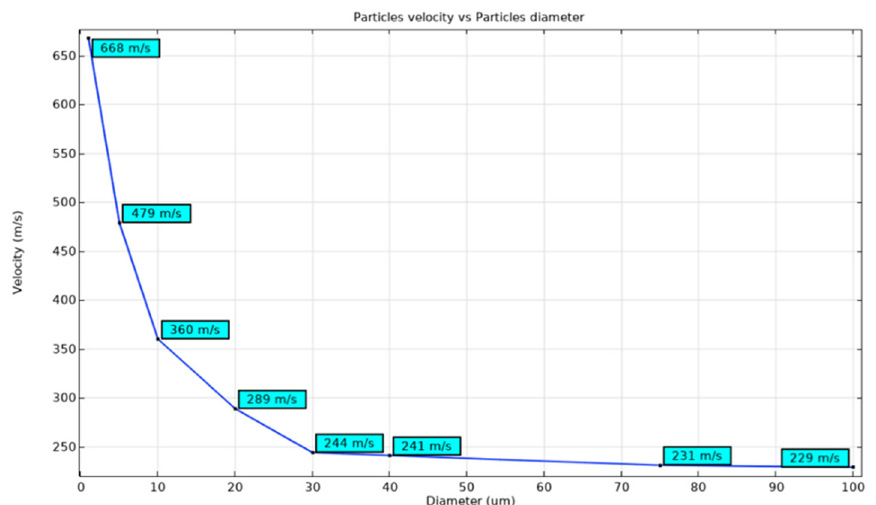
Figure 5. Particle impact velocity for different particle sizes.